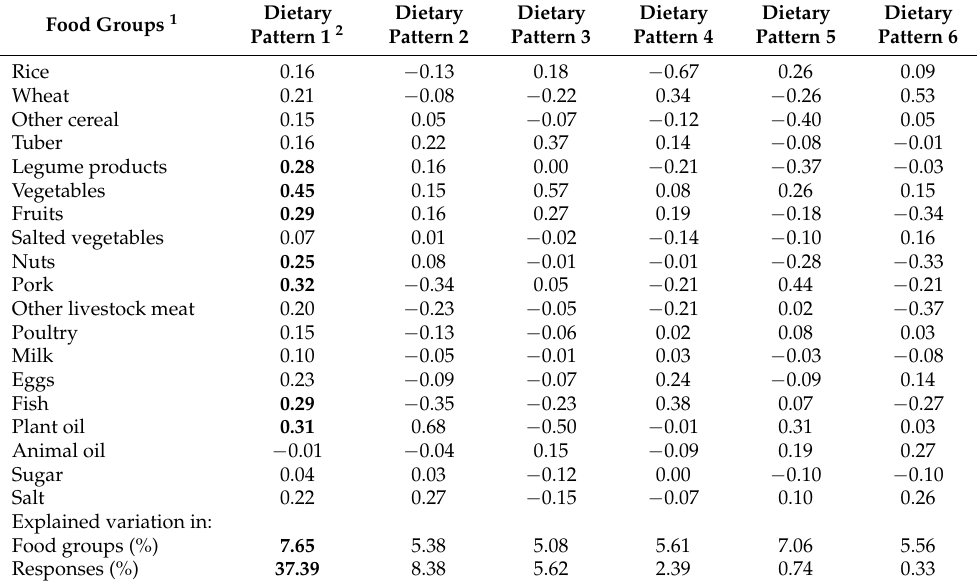
Table 1. Factor loadings of vitamin C, vitamin E, zinc, iron, copper, and selenium-related dietary patterns based on reduced rank regression (RRR) in Chinese adults aged ≥ 55 years